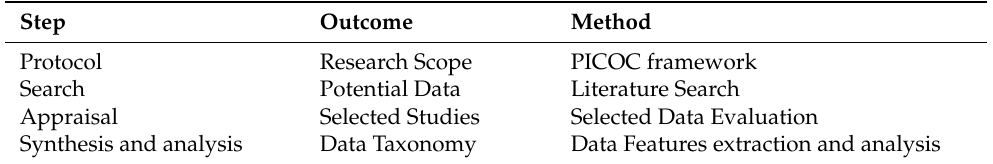
Table 2. Adopted SALSA